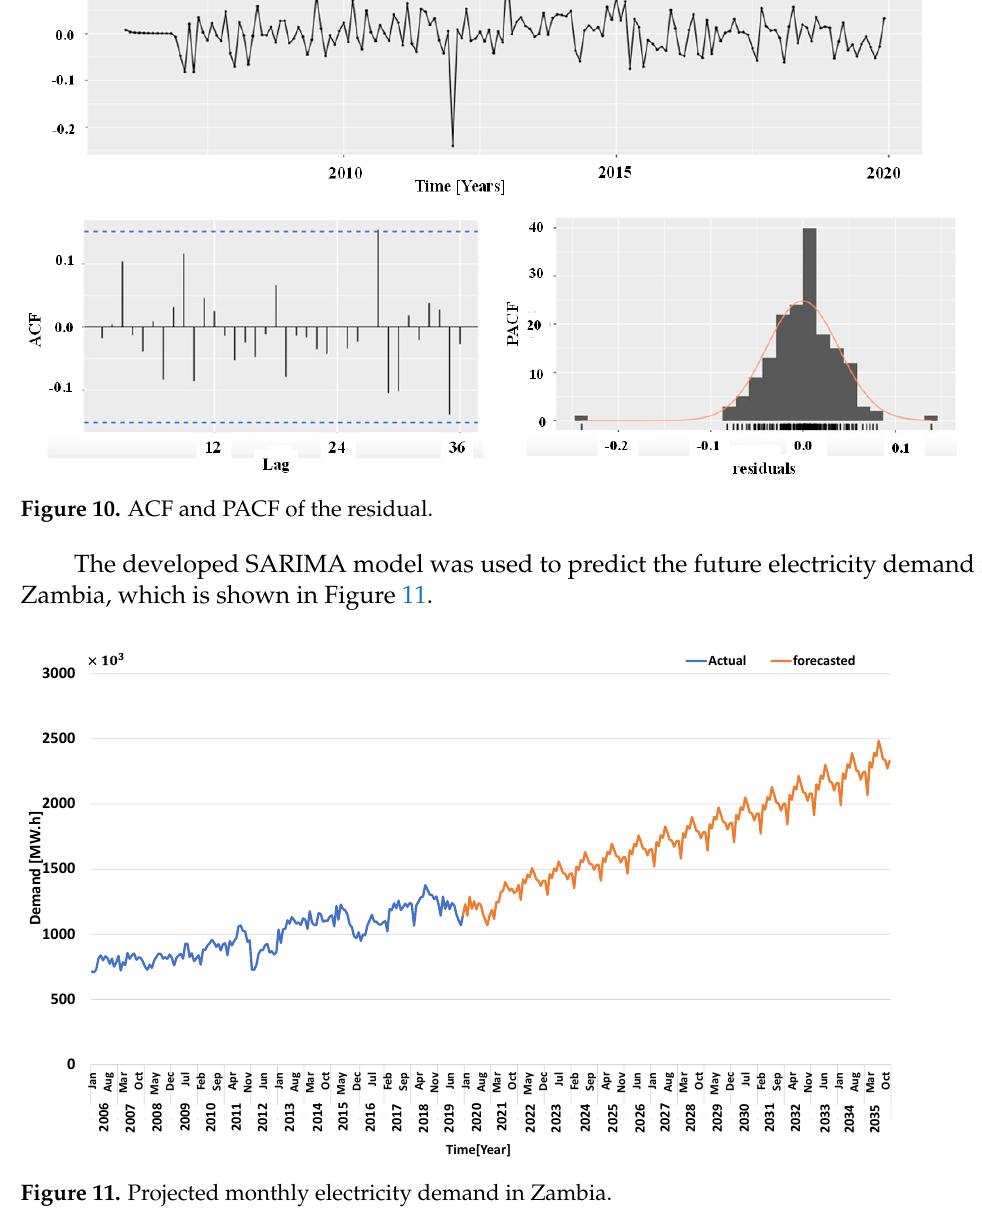
Figure 11. Projected monthly electricity demand in